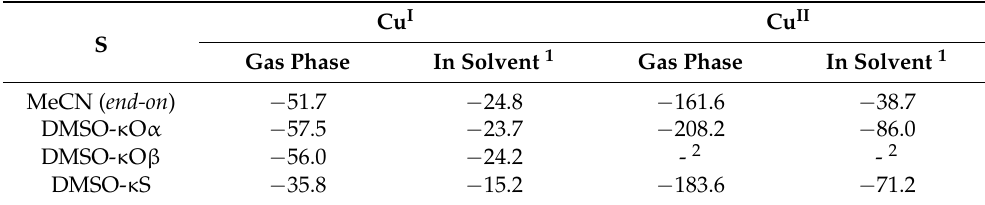
Table 3. ∆ G r (kcal/mol) of [Cu I/II (S)] +/2+ formation from Cu I/II and S (S=MeCN, DMSO) calculated in gas phase and in implicit solvent; level of theory: (PCM-)M06/6-311+G(d,p). Cu I Cu II S In Solvent